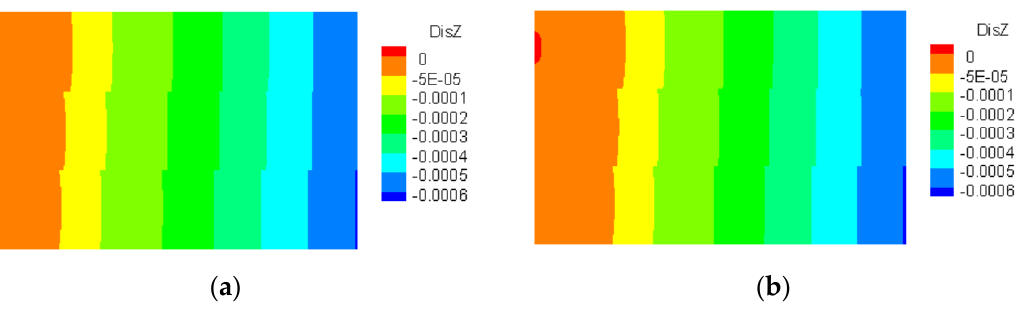
Fractal Fract. 2022 , 6 , 133 Figure 13. The distribution of displacement in Z-direction. ( a ) SBFEM. ( b ) ANSYS. Figure 13. The distribution of displacement in Z-direction. ( a ) SBFEM. ( b ) ANSYS. Figure 13. The distribution of displacement in Z-direction. ( a ) SBFEM. ( b ) ANSYS. Figure 13. The distribution of displacement in Z-direction. ( a ) SBFEM. ( b ) ANSYS.